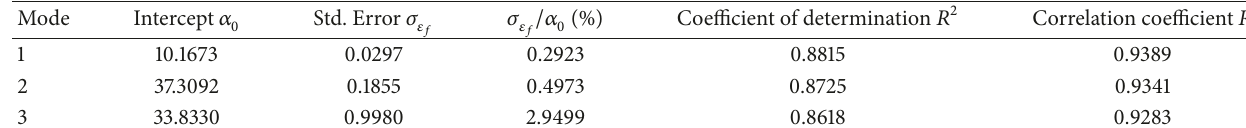
Table 10: Coefficients of linear regression model (frequency ∼ temperature + humidity) of girder No. 3.